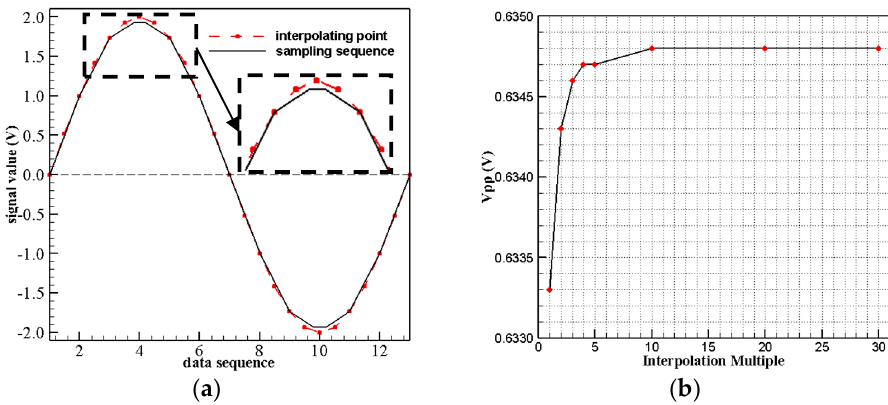
Figure 4. ( a ) Peak error caused by signal discontinuity; ( b ) Data interpretation effect comparison.